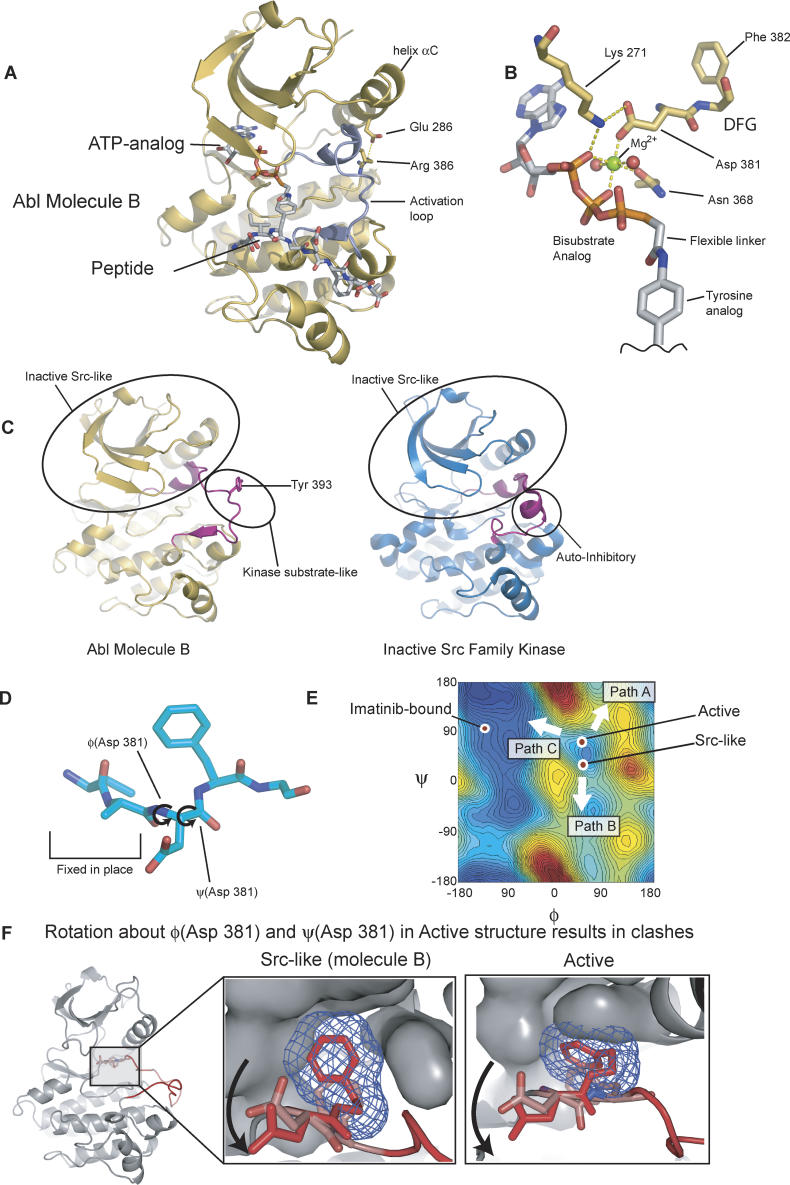
Molecule B Closely Resembles the Structure of the Inactive Src Kinases(A) The kinase domain of Abl (molecule B) is shown as a cartoon with the bisubstrate analog inhibitor depicted as a stick model.(B) Structure of the ATP–peptide conjugate at the active site.(C) Comparison between molecule B (left) and the structure of a Src-family kinase (right).(D) Backbone torsion angles of Asp 381 of the DFG motif.(E) The backbone of Asp 381 can start to move from DFG-In to the DFG-Out conformations by three paths in torsion angle space [
32].
(F) Illustration of rotations about ϕ(Asp 381) and ψ(Asp 381) in the Src-like inactive versus the active structures of Abl.